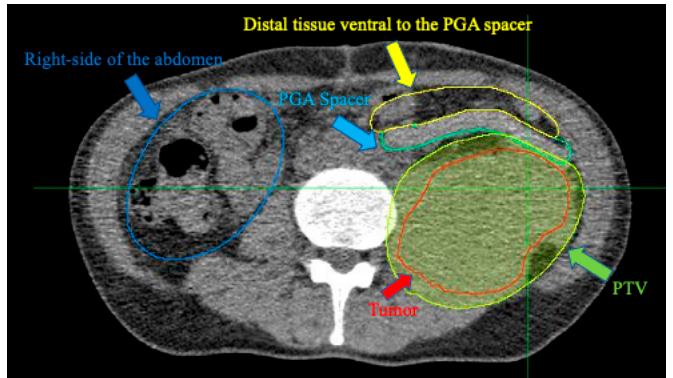
Figure 2. Contours on CT images used in CPS calculations. The red, light green, light blue, yellow, and blue outlines area and arrows reveal the tumor, PTV, the PGA spacer, distal tissue ventral to the PGA spacer (out of the irradiation field at the distal side), and the right side of the abdomen (out of the irradiation field on the lateral side).